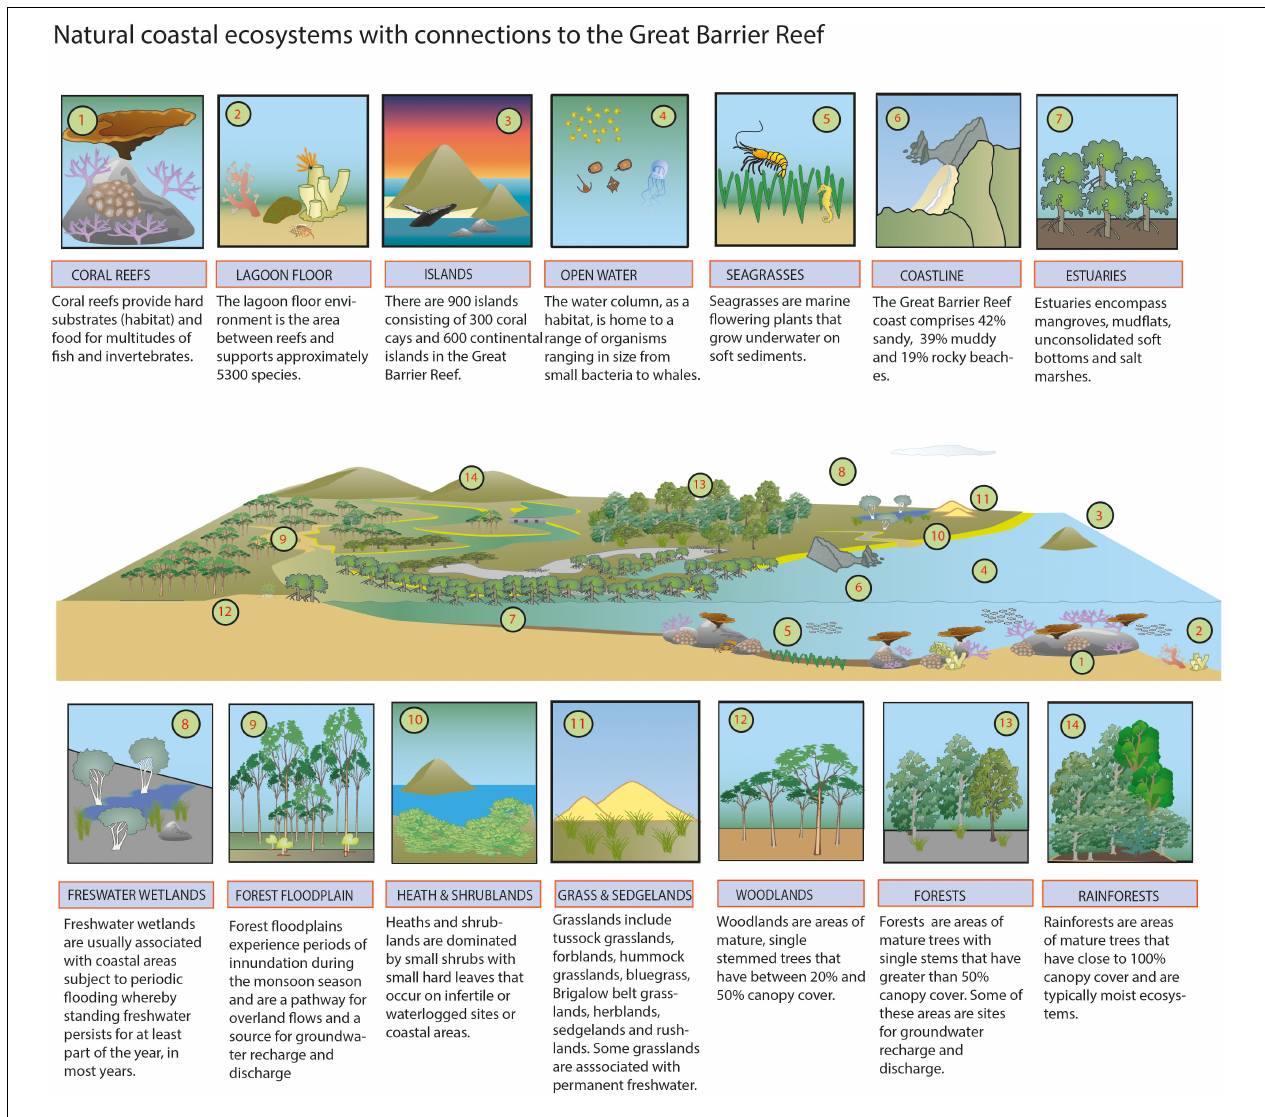
FIGURE 2 | The range of different coastal floodplain wetland habitats within the GBR lagoon, and a description for each